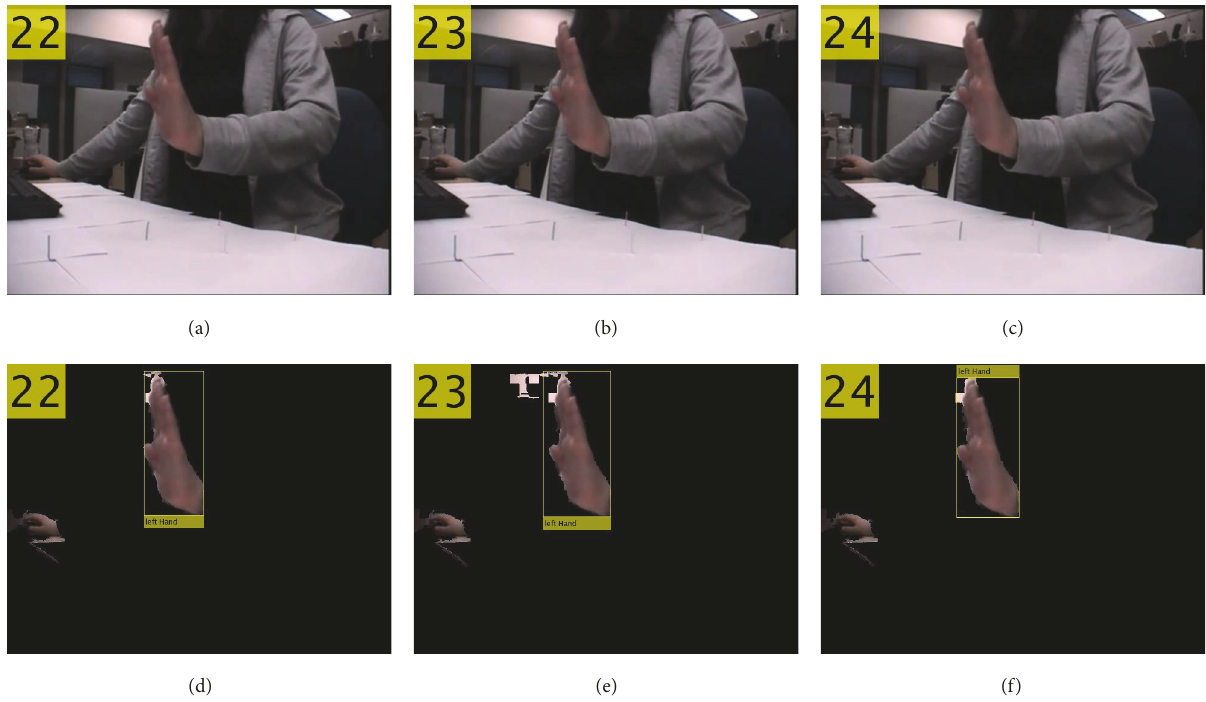
Figure 10: Sample frames clipped from gesture video with hand moving and overlapping with background noise. The first row ((a), (b), and (c)) shows the original frame captured by camera 𝐶 2 . The second row ((d), (e), and (f)) shows the tracking result.